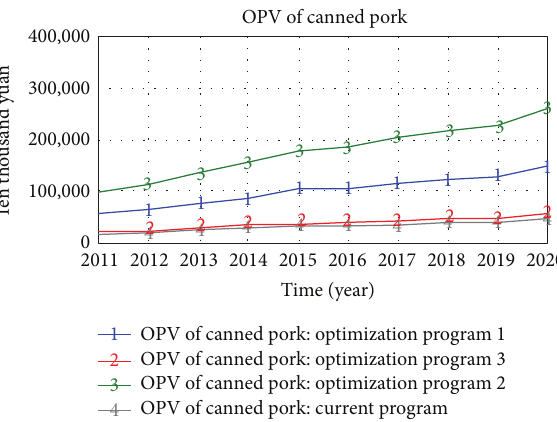
Figure 8: The output amount of preserved meat.